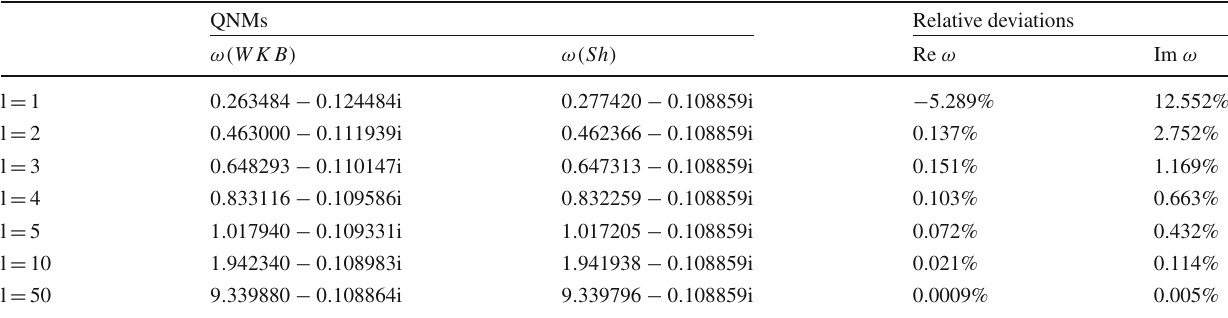
Table 6 The QNMs derived by the WKB approximation approach and shadow radius and the relative deviations. In the calculation, we let Q = 0 . 4 and α = − 1